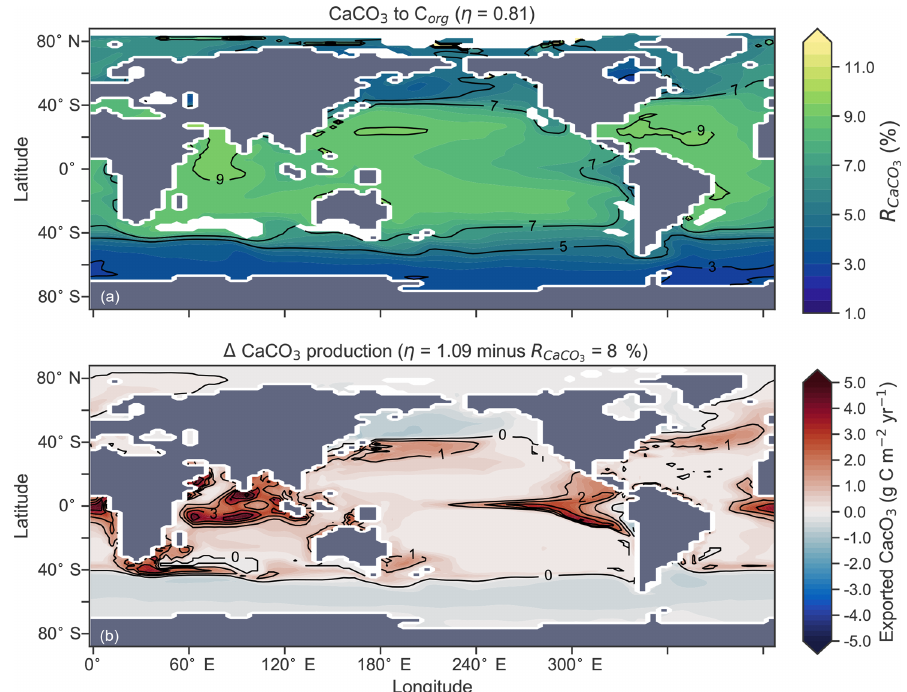
Figure 13. Global distribution of CaCO 3 export as a percentage of organic carbon (C org ) export (a) and the change in the CaCO 3 production field as a result of making CaCO 3 production dependent on calcite saturation state ( η = 1 . 09) compared to when it was a fixed 8% of C org (b) . Areas where export production does not occur due to severely nutrient limited conditions are masked out.